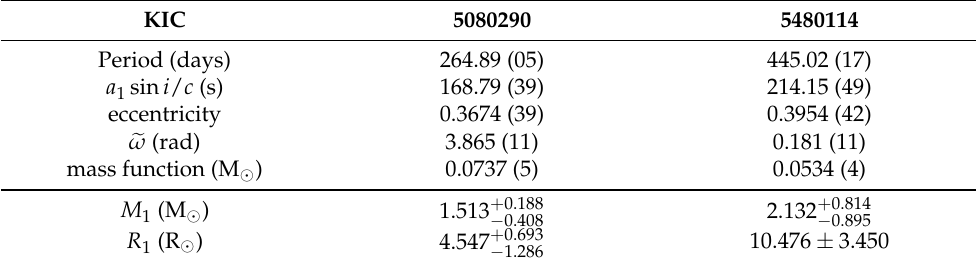
Table 1. Fitting parameters of KIC 5080290 and 5480114.